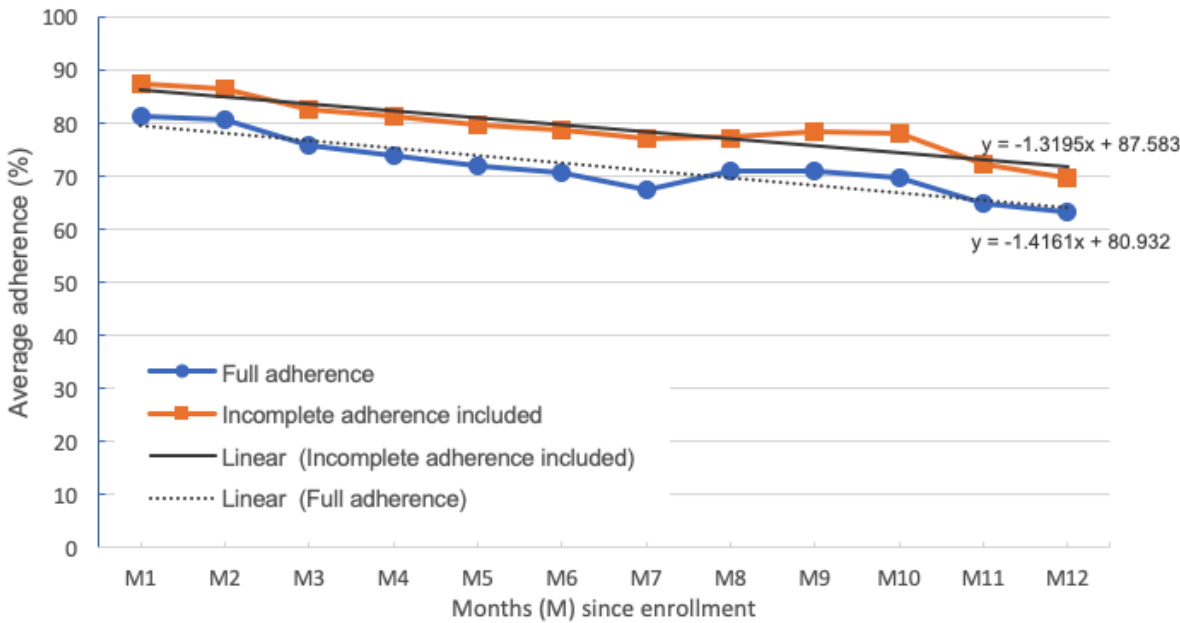
Figure 2. Average full adherence rates compared with adherence rates which include incomplete adherence over